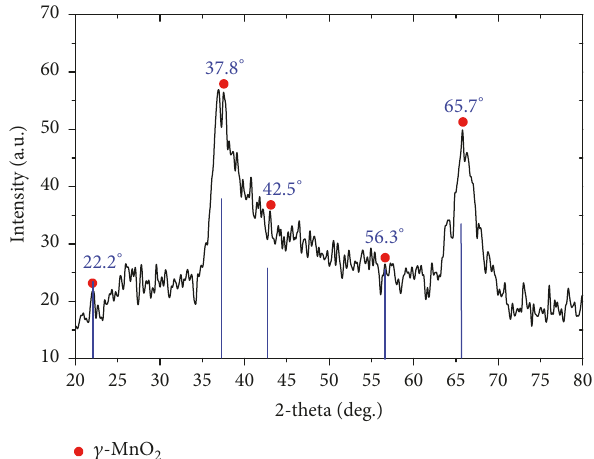
Figure 2: The XRD spectrum of the 𝛾 -MnO 2